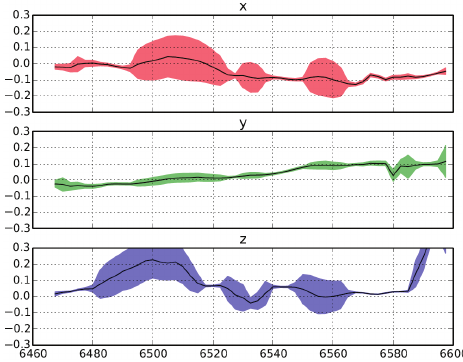
Figure 12. Determined shift at each reference point along trajectory after adjustment, exemplarily for scanner 1.